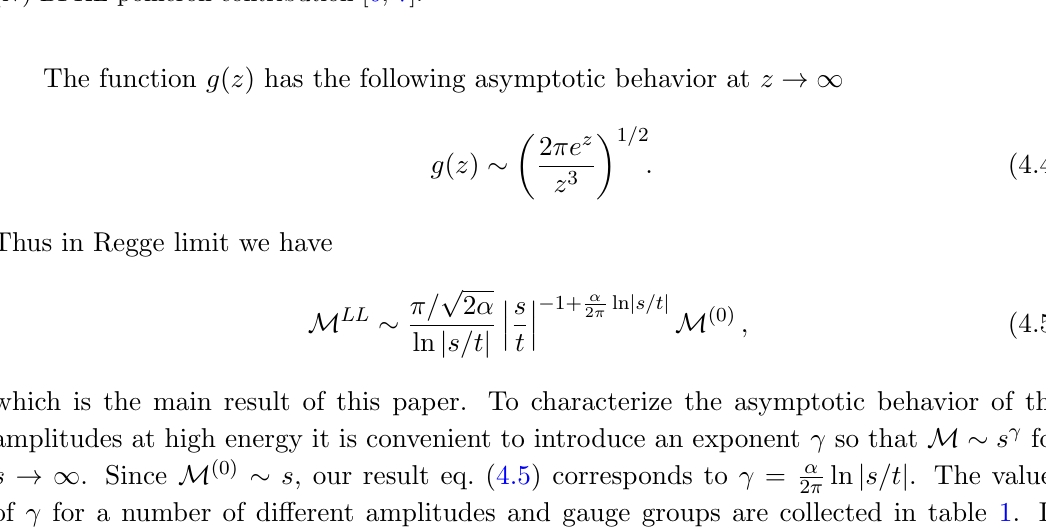
Table 1 . The exponent (cid:13) de(cid:12)ned in the text for (i) the subleading-power scattering, eq. (4.5); (ii) electron-to-muon pair forward annihilation amplitude [12]; (iii) QED Regge cut contribution [3, 4]; (iv) BFKL pomeron contribution [6,